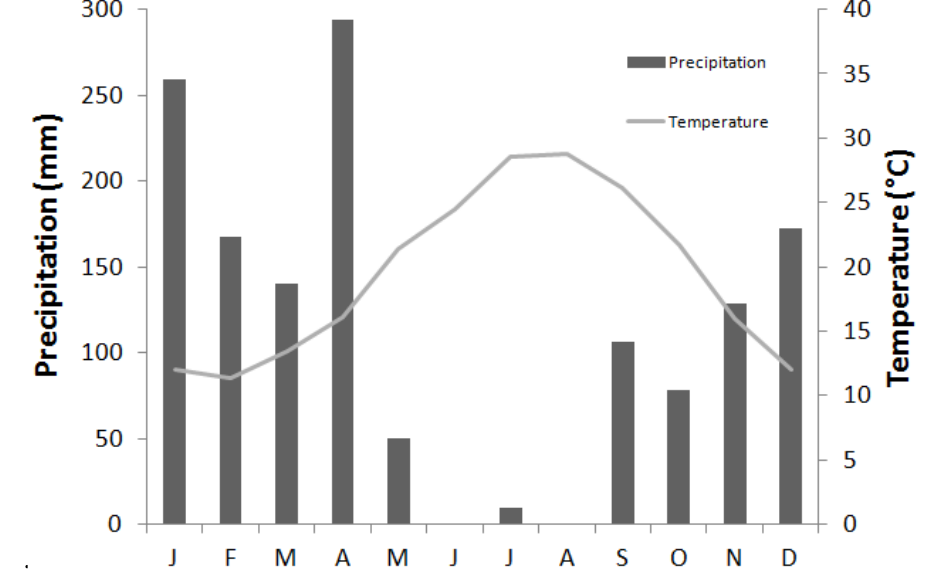
. Figure 2. Climate diagram for the 2008–2009 period in the Bellif study